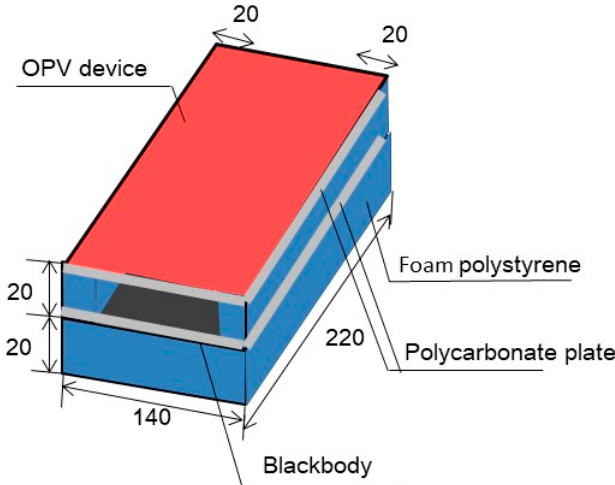
Figure 1. Projection drawing of small-scale OPV-solar chimney model (Unit: mm).